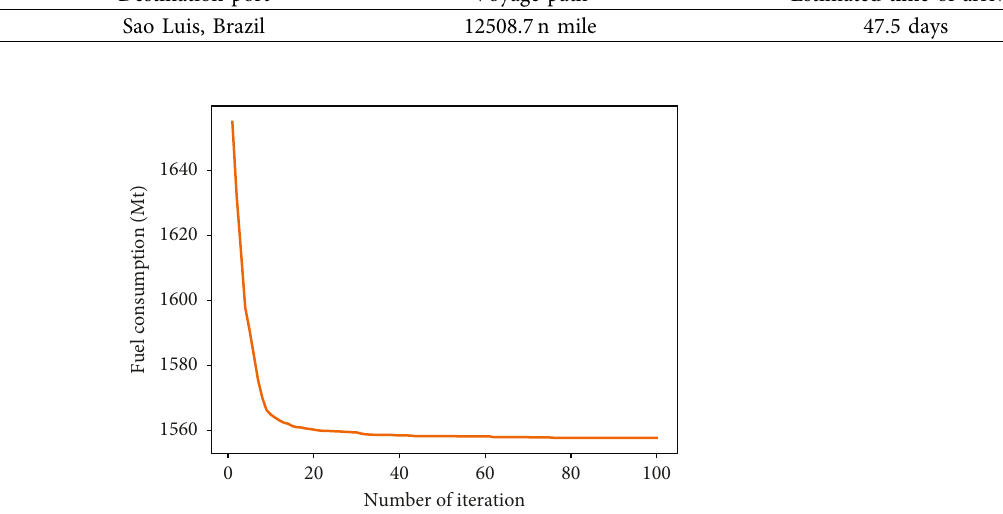
Figure 9: Fitness varies with iterations. Table 6: Results of speed